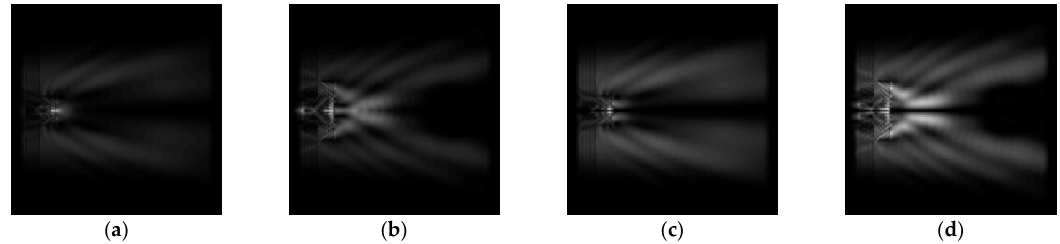
Figure 6. Comparison of silicon cylinders with circular polarization, plane xz, h = λ : ( a ) r = λ , “ − ” circular polarization, ( b ) r = 2 λ , “ − ” circular polarization, ( c ) r = λ , “+” circular polarization, ( d ) r = 2 λ , “+” circular polarization.